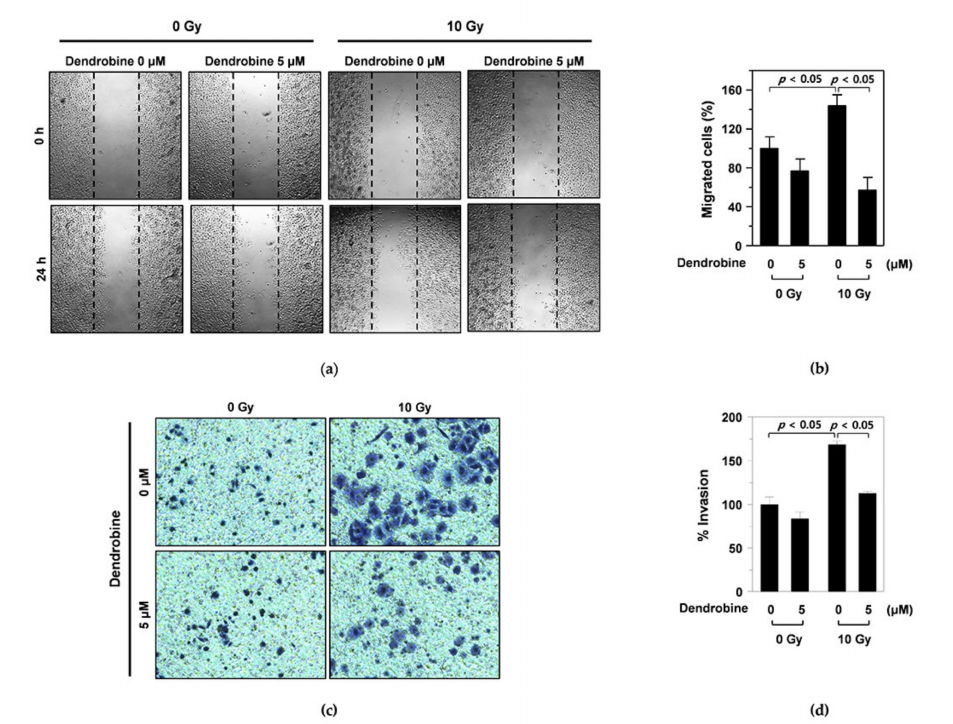
Figure 2. Inhibitory effect of dendrobine on IR-induced migration and invasion of A549 lung cancer cells. ( a ) The inhibitory activity of dendrobine on IR-induced migration was measured using a wound healing assay. ( b ) Quantification of the migrated cells. The relative migrated cells were calculated as the ratio of the migrated cells at a given time point at 0 h. Data represent the mean ± SD ( n = 3). ( c ) The inhibitory activity of dendrobine on IR-induced invasion was determined using an invasion assay. ( d ) Quantification of invasion. The percentage of invasion is represented as the number of cells per field compared with the control (0 Gy/0 µ m of dendrobine) group. Data represent the mean ± SD ( n =